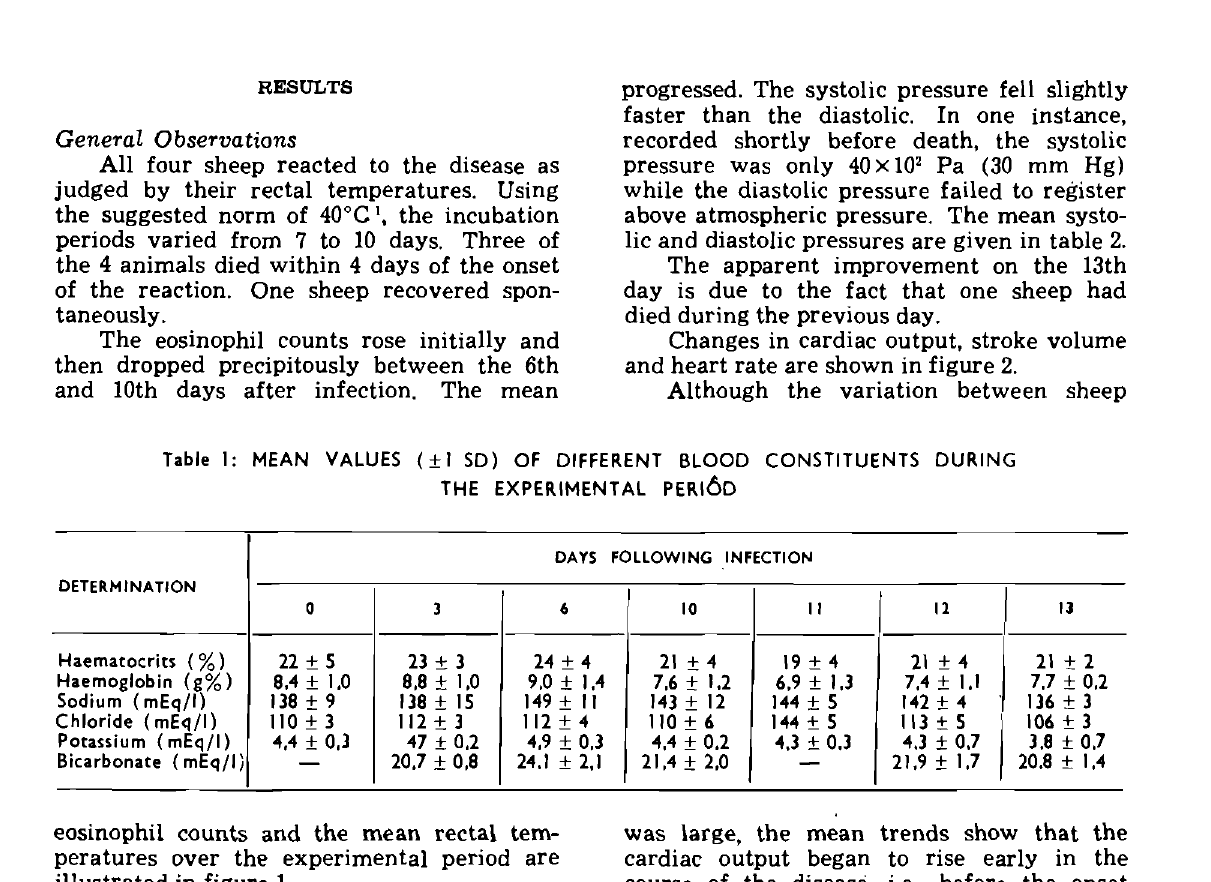
Table 2: MEAN SYSTOLIC AND DIASTOLIC BLOOD PRES~URE VALUES DURING THE EXPERIMENTAL